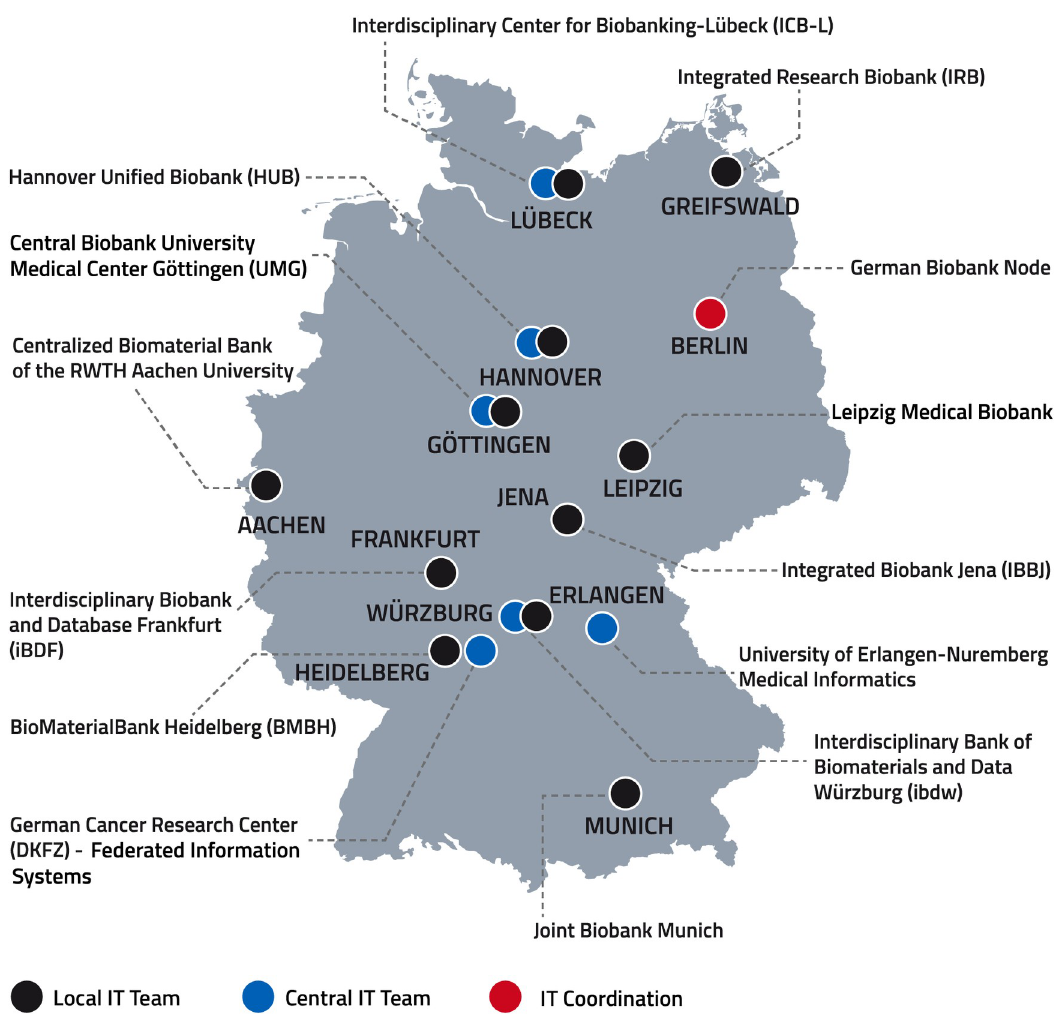
Fig 1. Overview of the partners sites including biobanks, IT teams and GBN at project launch 2017. Printed under a CC BY license, with permission from the German Biobank Node, original copyright